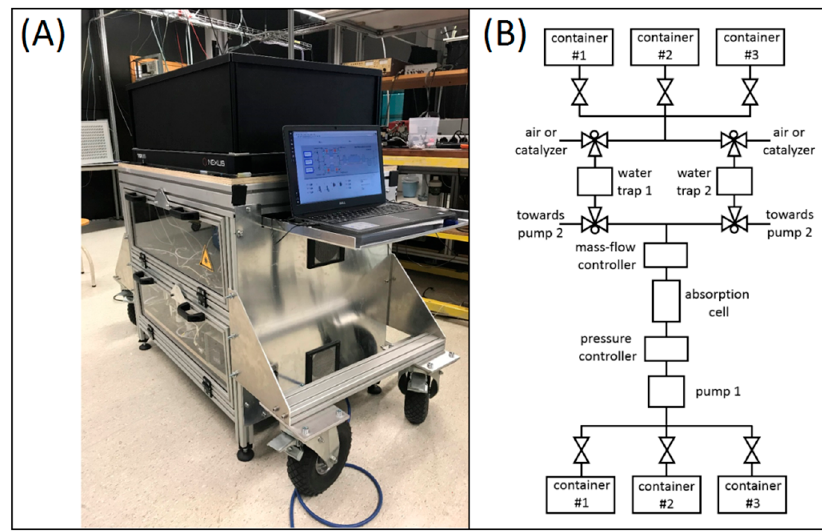
Figure 3. ( A ) Overview of the transportable and integrated gas sensing platform. ( B ) Schematic overview of the gas handling system.